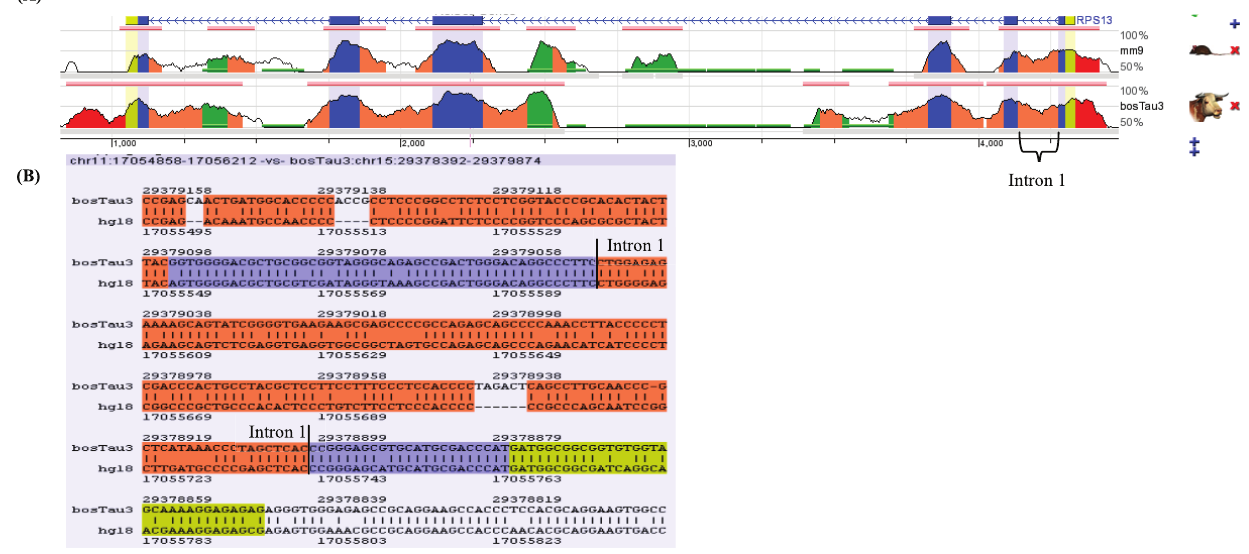
Figure 2. The RPS3 gene. (A) Conservation of the gene RPS13 among human, mouse and cow. Yellow bars, UTRs; Blue bars exons; Orange bars, Intron; Green bar, repetitive elements. The conserved retained intron is indicated (braces). (B) Alignment of UTR-Exon1-Intron1-Exon2-Intron2. The start and end of the conserved intron is indicated by vertical bars. doi:10.1371/journal.pone.0011695.g002 PLoS ONE |